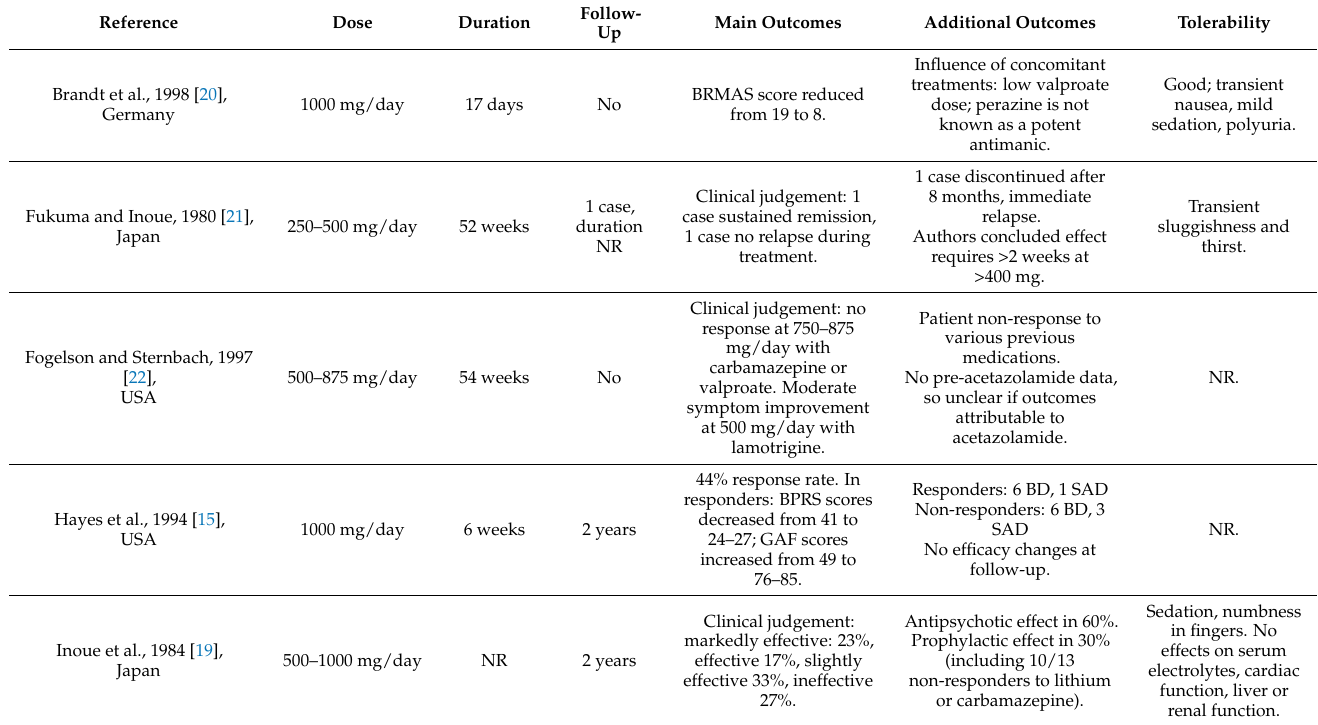
Table 2. Characteristics of acetazolamide